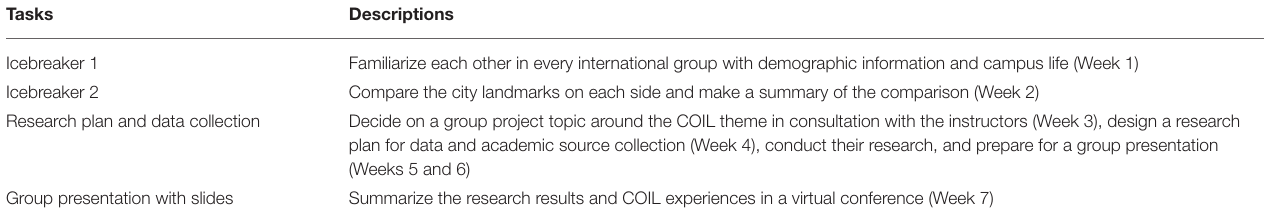
TABLE 1 | General description of the COIL projects.